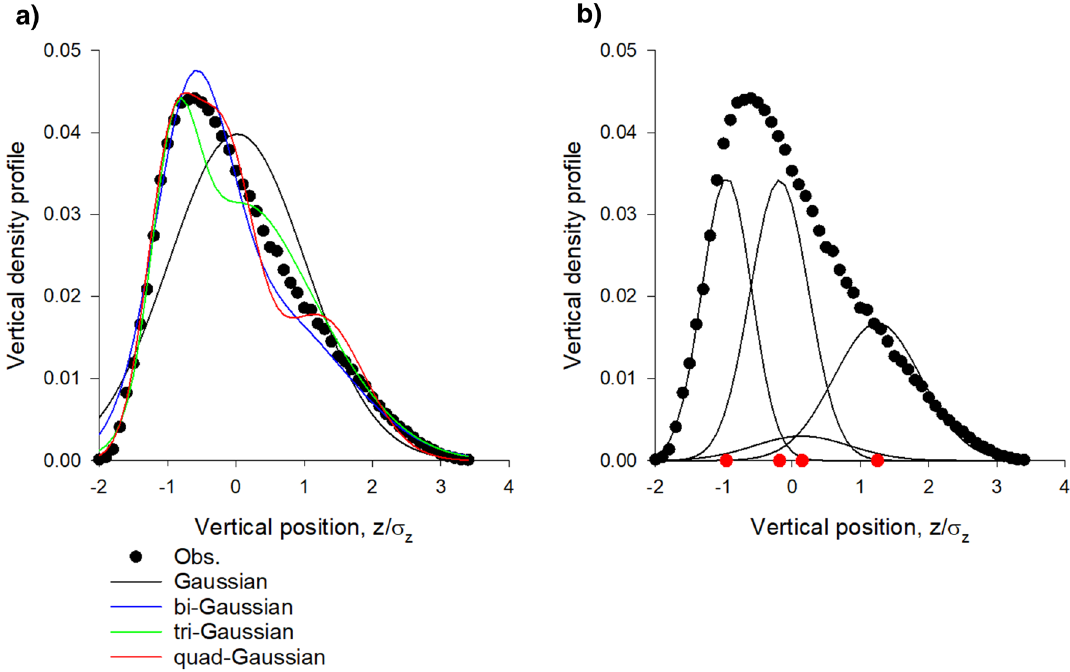
Figure 1. ( a ) Vertical density profiles of laboratory swarms are accurately represented by superpositions of Gaussians. ( b ) Constituent Gaussians in the quad-Gaussian representation with centres at •. In accordance with observations, the best superposition “ contains around 3 horizontal layers, with the lowest layer being flattered than the others” [van der Vaart, Private Communication]. The Akaike weights for the single-, bi-, tri- and quad- Gaussian fits are 0.00, 0.00, 0.08 and 0.92 indicating strong support for the quad-Gaussian representation (albeit with one weak ‘embryonic’ slab). Data are taken from Sinhuber et al. 14 : swarm Ob1 which contains on average 94 individuals. The swarm is centred on z =